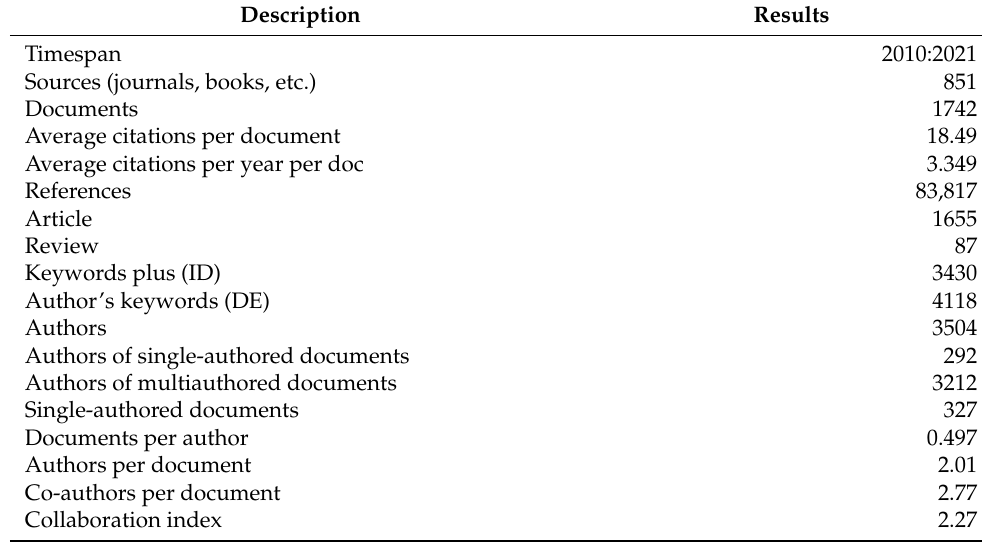
Table 1. Data characteristics.